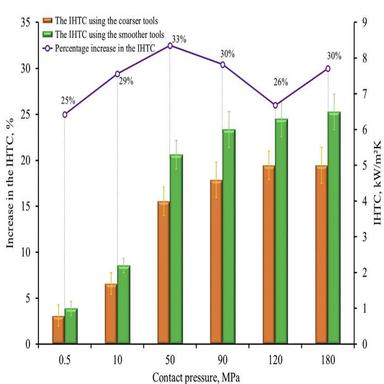
The percentage increase in the IHTC for the Ti-6Al-4V when the tool surface roughness decreased from 980 to 650 nm at different contact pressures.